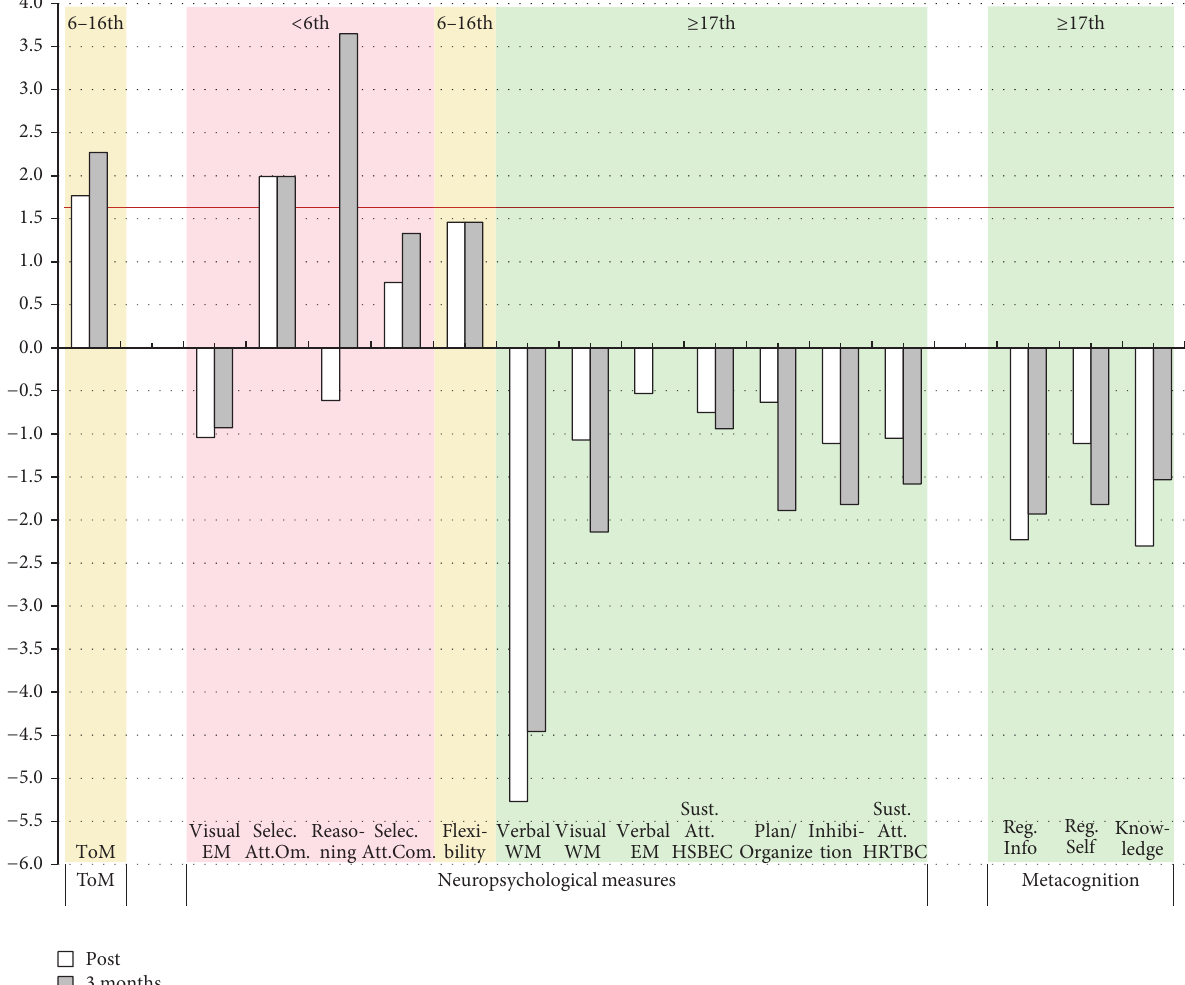
collaboration and motivation as reported by the